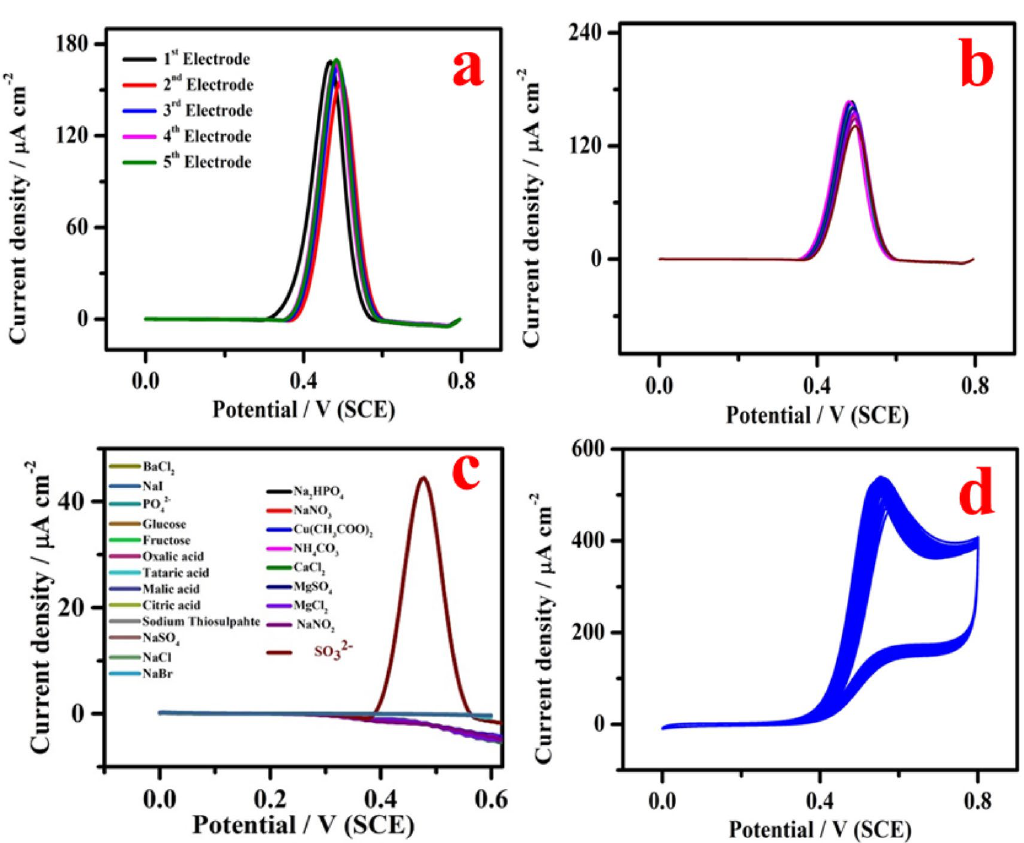
Figure 10. ( a , b ) Fabrication reproducibility (five electrodes) and repeatability of CuO/GCE by DPV technique in the existence of 5 mM SO 3 2− . ( c ) Selectivity of CuO/GCE by DPV response in the presence of 0.5 mM SO 3 2− and ( d ) stability study of CuO/GCE for the electrooxidation of 5 mM SO 3 2− . (DPV parameters: step potential = 0.0050 V; modulation amplitude = 0.0250 V; modulation time = 0.20 s and interval time-0.5 tion condition then employed to record the electrochemical response of 5 mM SO 32− and the obtained results are displayed in Fig. 10a. The RSD was found to be 4.1%, which indicates good reproducibility of the sensors made in the same way. Typically, the response of a modified electrode to an analyte decreases after several measure- ments. In this context, we have evaluated the repeatability of CuO modified electrode in sulphite estimation by continuously monitoring the electrochemical response of 5 mM SO 32− for every 4 min interval for 10 measure-